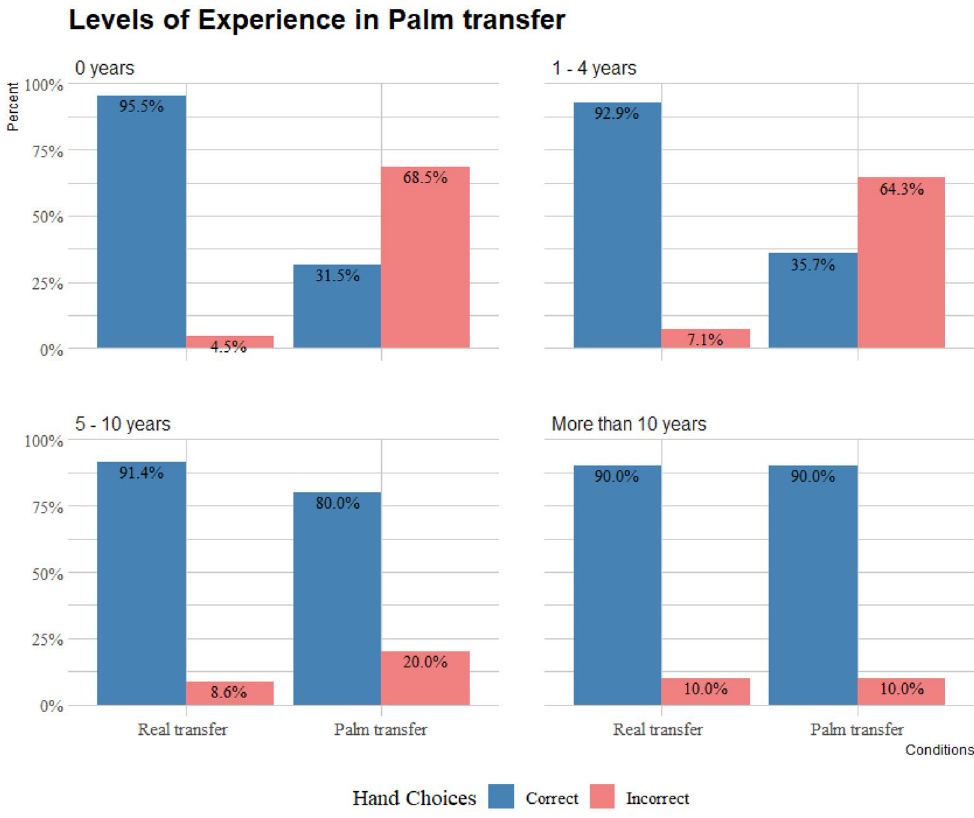
Figure 3. Choices in palm transfer, and real transfer counterpart separated by levels of experience practicing